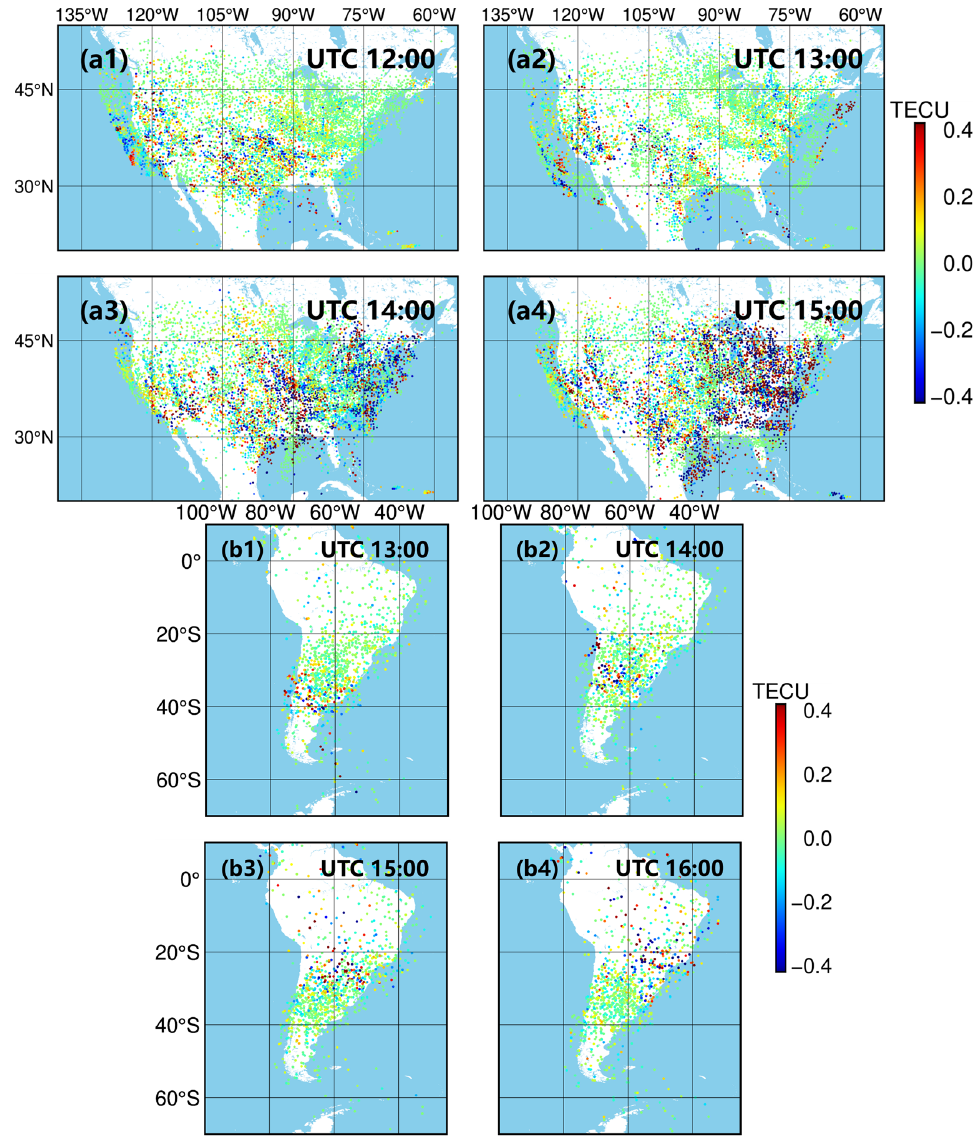
Figure 5 . The propagation of TID in the eastern Pacific Rim ( a1–a4 ) Native US ( b1–b4 ) South Figure 5. The propagation of TID in the eastern Pacific Rim ( a1 – a4 ) Native US ( b1 – b4 ) South America .